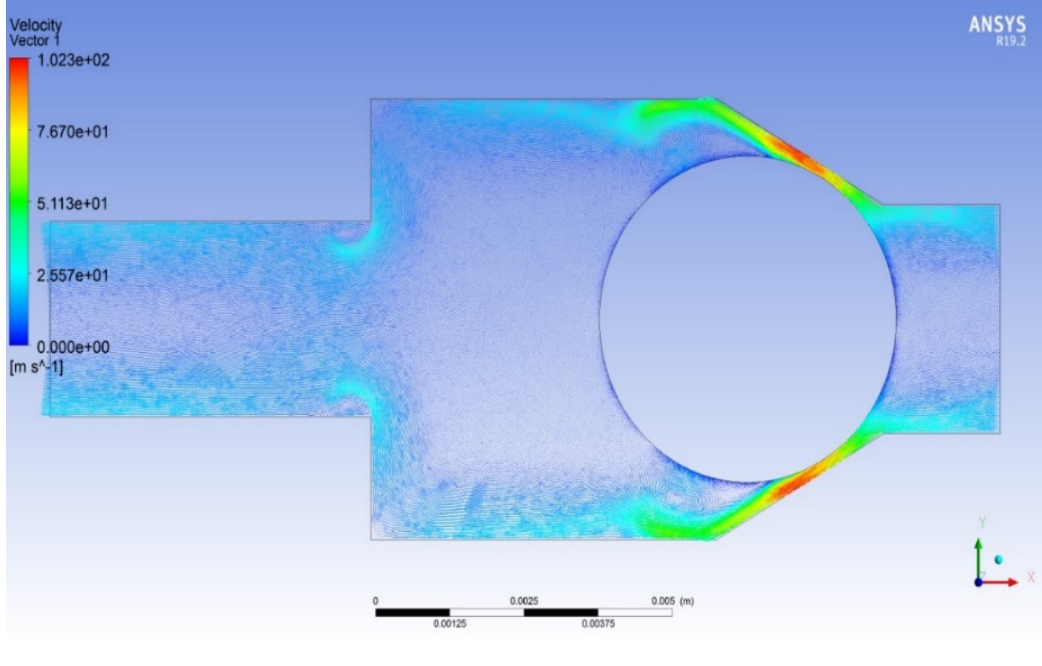
Figure 13. Velocity CFD: Conical Seat Valve: x = 0.201 [mm], pdn = 300 [bar] and pup = 330 [bar].